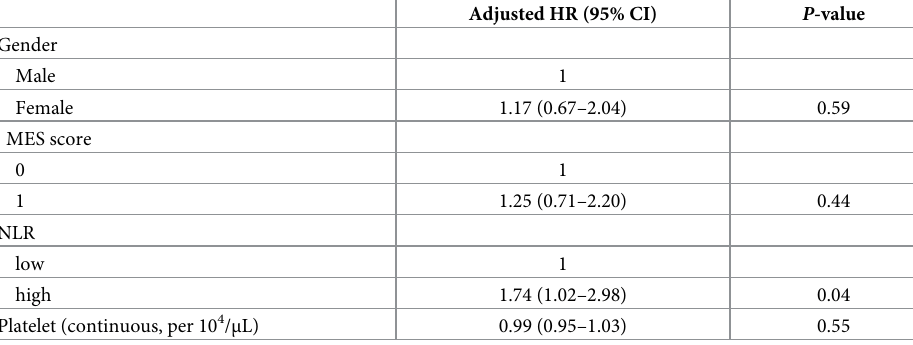
Table 4. Cox proportional hazards regression of risk for clinical